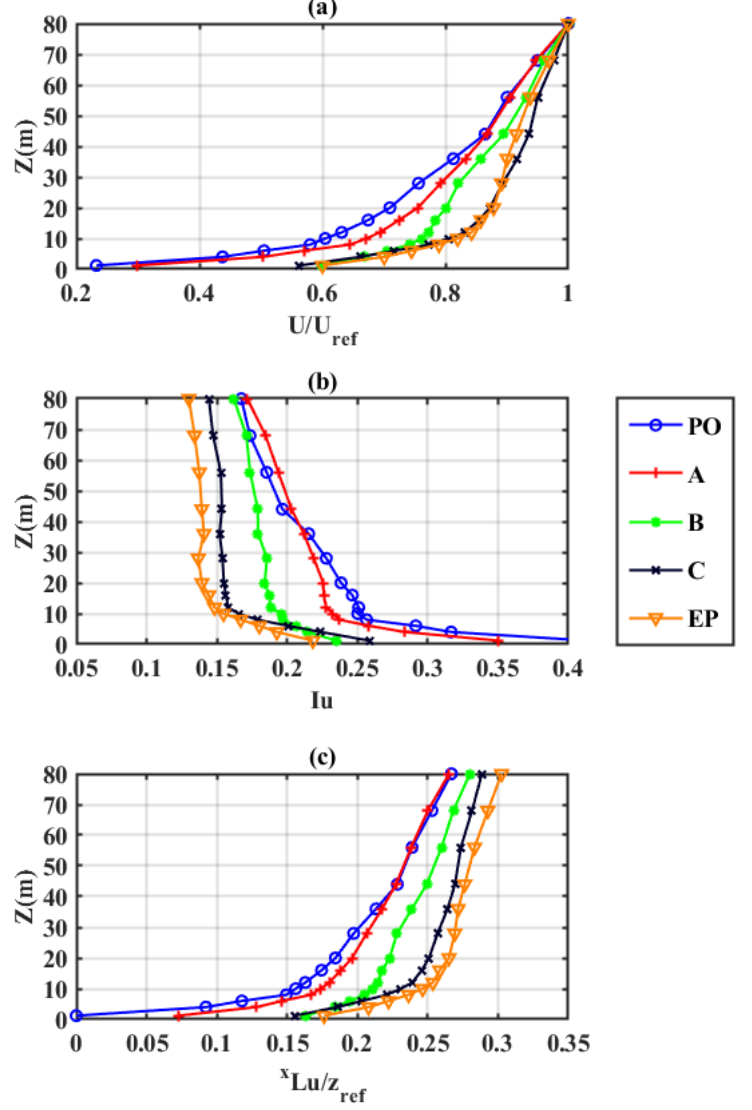
Figure 3. ( a ) Mean velocity normalized with the reference velocity. ( b ) Turbulence intensity. ( c ) Inte- gral length scale normalized with the reference height for the first 80 m in full-scale of generic